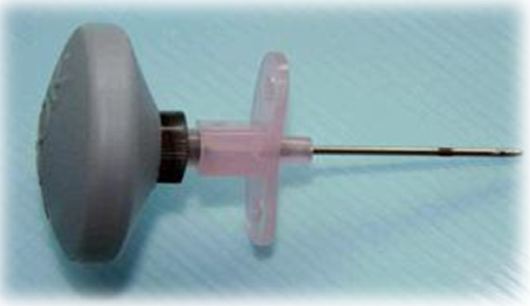
Figure 1. Cook Dieckmannn intraosseous needle. Source: NPunto Magazine , 2019 (1). Among the devices for placement by firing, we can distinguish those intended for sternal access (FAST) and those that are not (BIG) [1,2]. The FAST I device (First Access for Shock and Trauma) creates a channel that allows the administration of fluids through the sternum (Figure 2). It is a set of needles around a central unit that is attached to a Luer-Lock type connector. The kit contains an introducer, a line extension system, an adhesive patch, a protective dome, and a dressing to disinfect the skin [1].